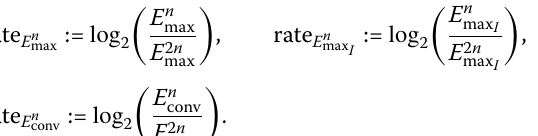
Table 1 Errors and order convergence for u 1, β ex using (41) with r = 2– β r = 2– β β n = 32 β =